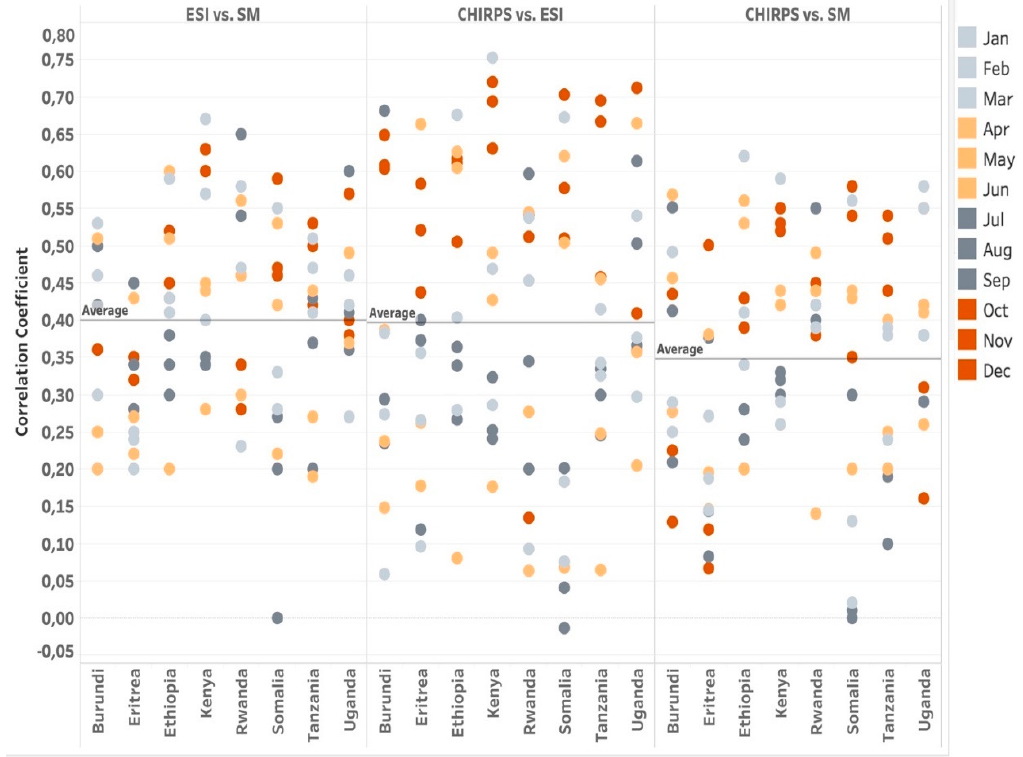
Figure 6. Monthly correlation coefficient between Evaporative Stress Index (ESI) and soil moisture (left), Climate Hazards Group InfraRed Precipitation with Station data (CHIRPS) and ESI (middle), CHIRPS and soil moisture for 2003–2016 for all countries (no mask applied); light-grey and orange represent the first half of the year, dark-grey and orange the second half.